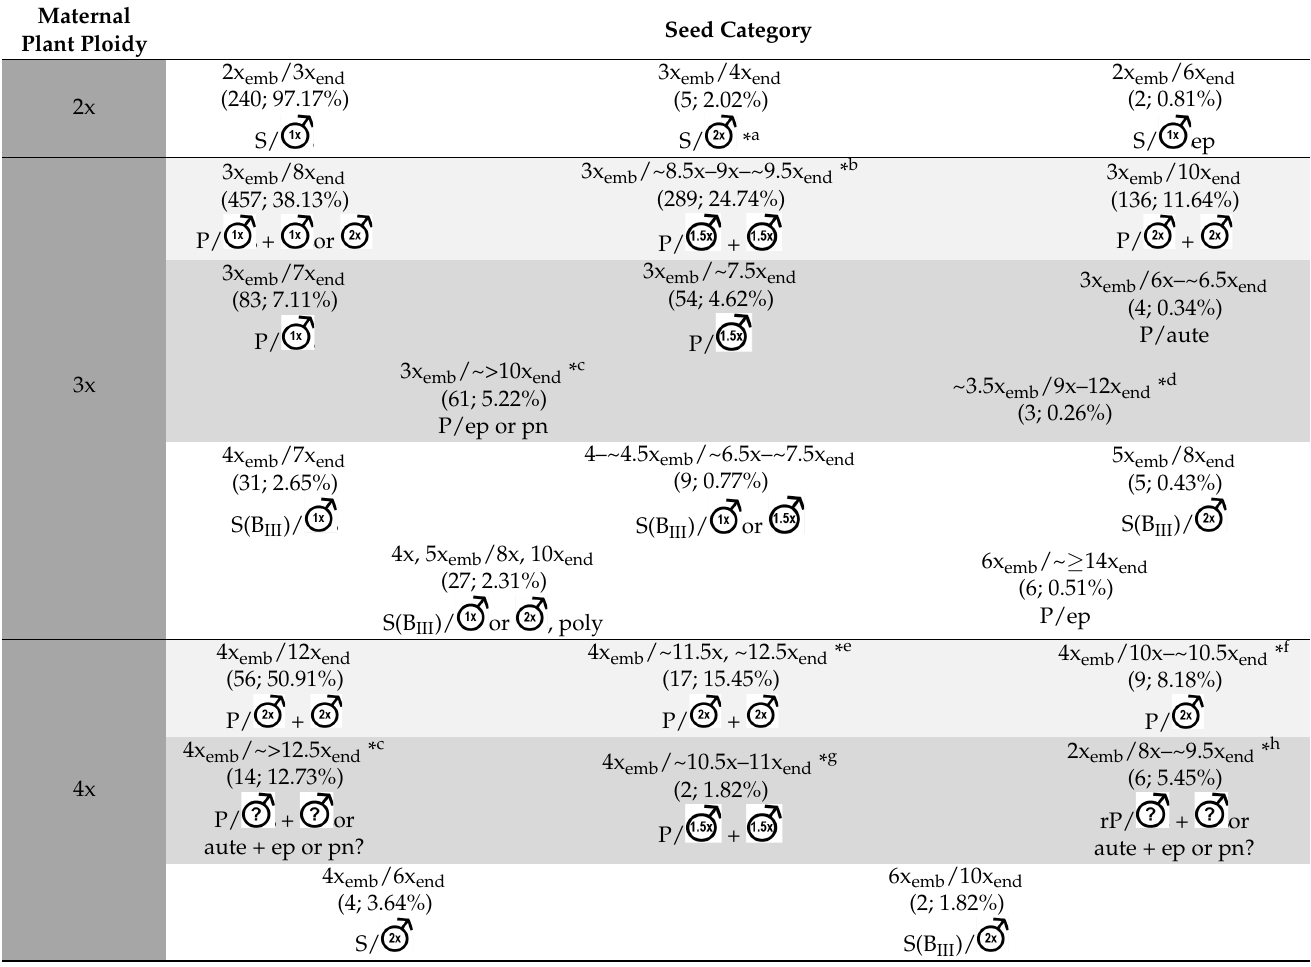
S(B III )/ * a the reduced 2x pollen from 4x plants or the unreduced 2x pollen from 2x plants. * b the measured ~9.5x endosperms could indicate double fertilization of the central cell by aneuploid pollen higher than 1.5x (but 1.5x < 2x). * c unresolved contribution of sperm cells; the cases here may involve even